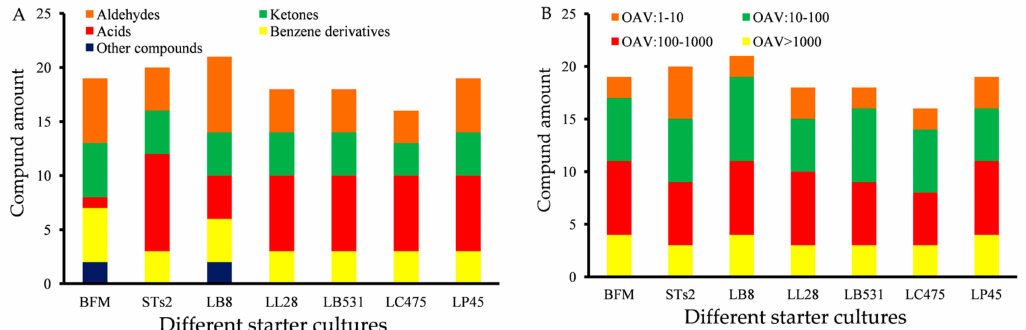
Figure 2. ( A ) Distribution of odor-active compounds in milks fermented by di ff erent starter cultures based on type of compounds. ( B ) Distribution of odor-active compounds in milks fermented by di ff erent starter cultures based on the level of odor activity values (OAVs).